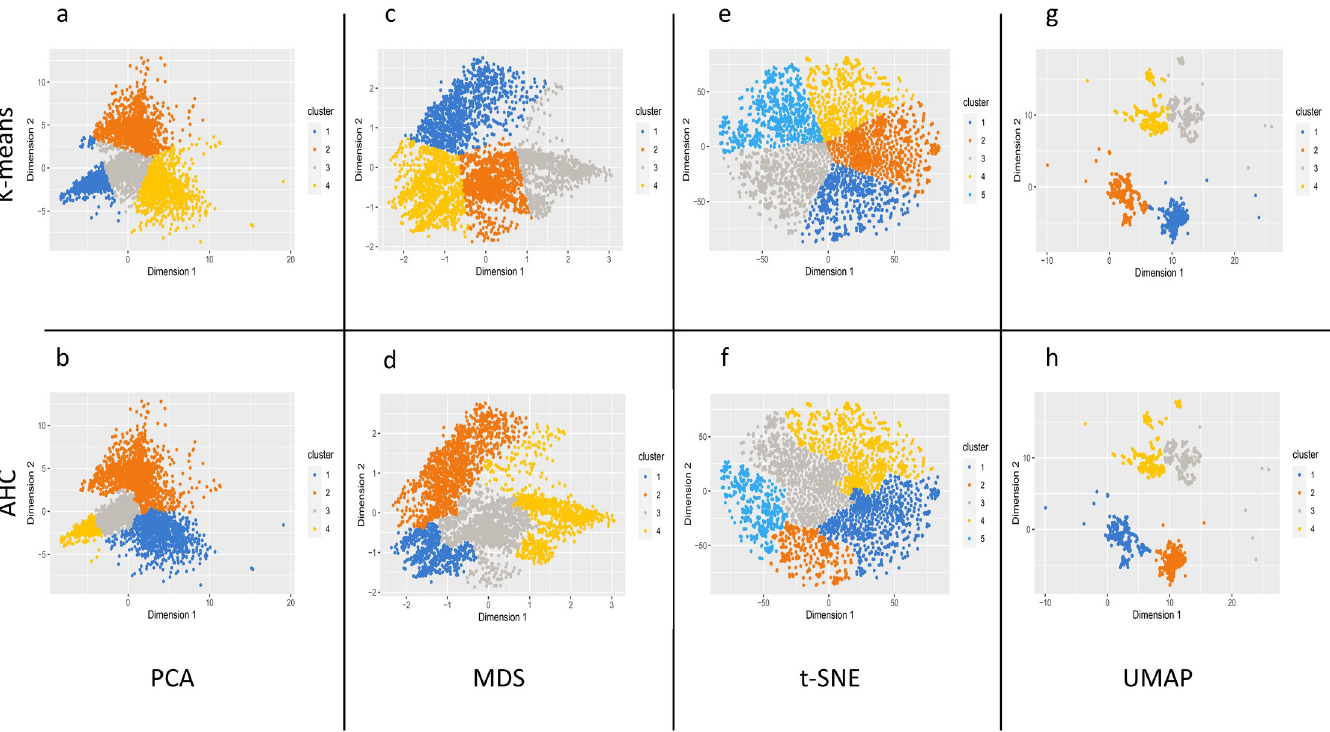
Fig 3. Visualization of the compounds-odors dataset in the 2-two dimensional spaces obtained after dimension reduction using PCA, MDS, t-SNE and UMAP. The data are colored according to the clusters produced by the k-means clustering and AHC that were carried out on the basis of the coordinate in the 2D spaces. The colors allow only to visualize the clusters easily and are specific to each method; there is no correspondence between the colors according to the several methods. The data are reported in S1 Table. (a) Clusters obtained by the PCA k-means approach: the clusters C1a, C2a, C3a and C4a encompass respectively 1523, 1466, 1622 and 1427 smell compounds; (b) Clusters obtained by PCA AHC approach: the clusters C1b, C2b, C3b and C4b encompass respectively 1461, 1756, 1997 and 824 smell compounds; (c) Clusters obtained by MDS k-means approach: the clusters C1c, C2c, C3c and C4c encompass respectively 1312, 1774, 1468 and 1484 smell compounds; (d) Clusters obtained by MDS AHC approach: the clusters C1d, C2d, C3d and C4d encompass respectively 854, 1551, 1970 and 1663 smell compounds; (e) Clusters obtained by t- SNE k-means approach: the clusters C1e, C2e, C3e, C4e and C5e encompass respectively 1008, 1375, 1225, 1122 and 1308 smell compounds; (f) Clusters obtained by t- SNE AHC approach: the clusters C1f, C2f, C3f, C4f and C5f encompass respectively 1480, 636, 1633, 1524 and 765 smell compounds; (g) Clusters obtained by UMAP k- means approach: the clusters C1g, C2g, C3g and C4g encompass respectively 1597, 1344, 1454 and 1643 smell compounds; (h) Clusters obtained by UMAP AHC approach: the clusters C1h, C2h, C3h and C4h encompass respectively 1640, 1584, 1332 and 1482 smell compounds. In each chart, C1, C2, C3, C4 and C5 clusters are depicted respectively in blue, orange, grey, yellow and light blue.